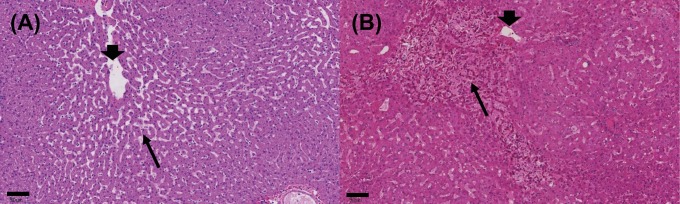
Liver sinusoidal dilation.(A) NHP administered 50 mg/kg anti-DLL4 and (B) CRLM patient treated with oxaliplatin both have sinusoidal dilatation in the centrilobular area near the central vein with a severity grade of 3. Thin arrows point to dilated sinusoids, and thick arrows to the central veins. The human liver (B) has blood retained within the dilated sinusoids that imparts a pink color. Scale bar = 90 μm.